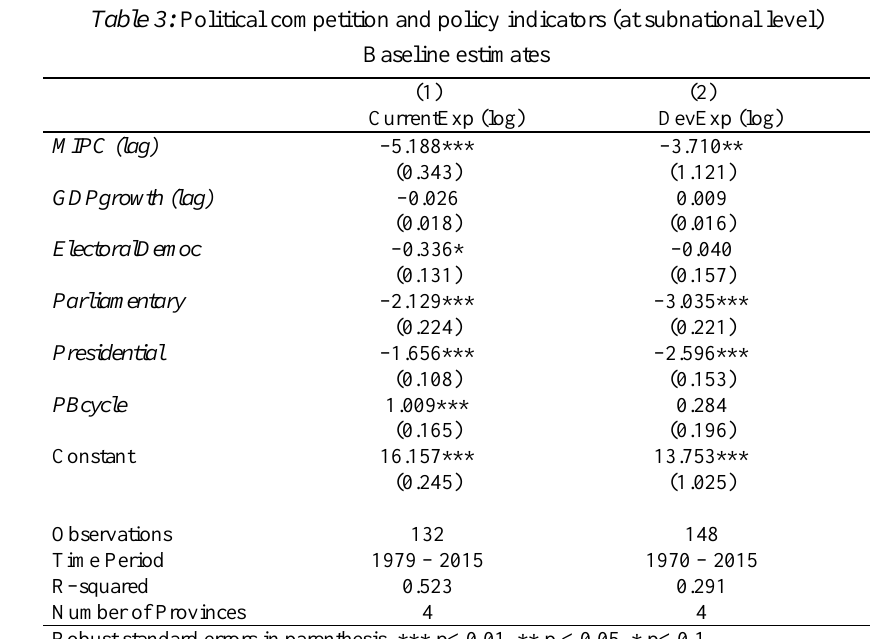
Table 3: Political competition and policy indicators (at subnational